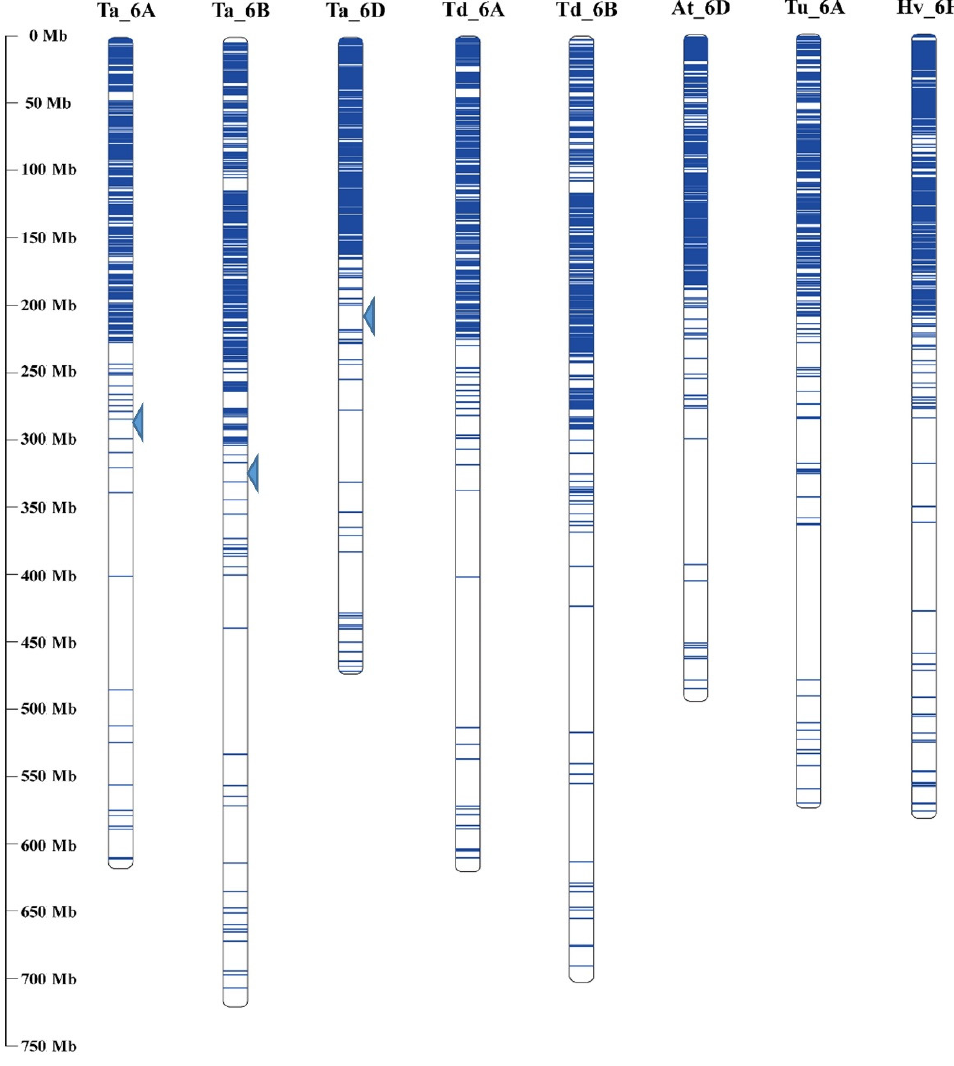
Figure 2. Comparative analysis of 6VS DNA sequence. The distinguish of 6VS homologous genes in group 6 of Triticeae genomes. The blue lines represent the homologous genes of 6VS located on the chromosomes of Triticeae genome. Ta, Td, At, Tu and Hv represent T. aestivum , T. dicoccoides , Ae. tauschii , T. urartu and H. vulgare , respectively. The blue arrows represent the position of the centromere of common wheat.